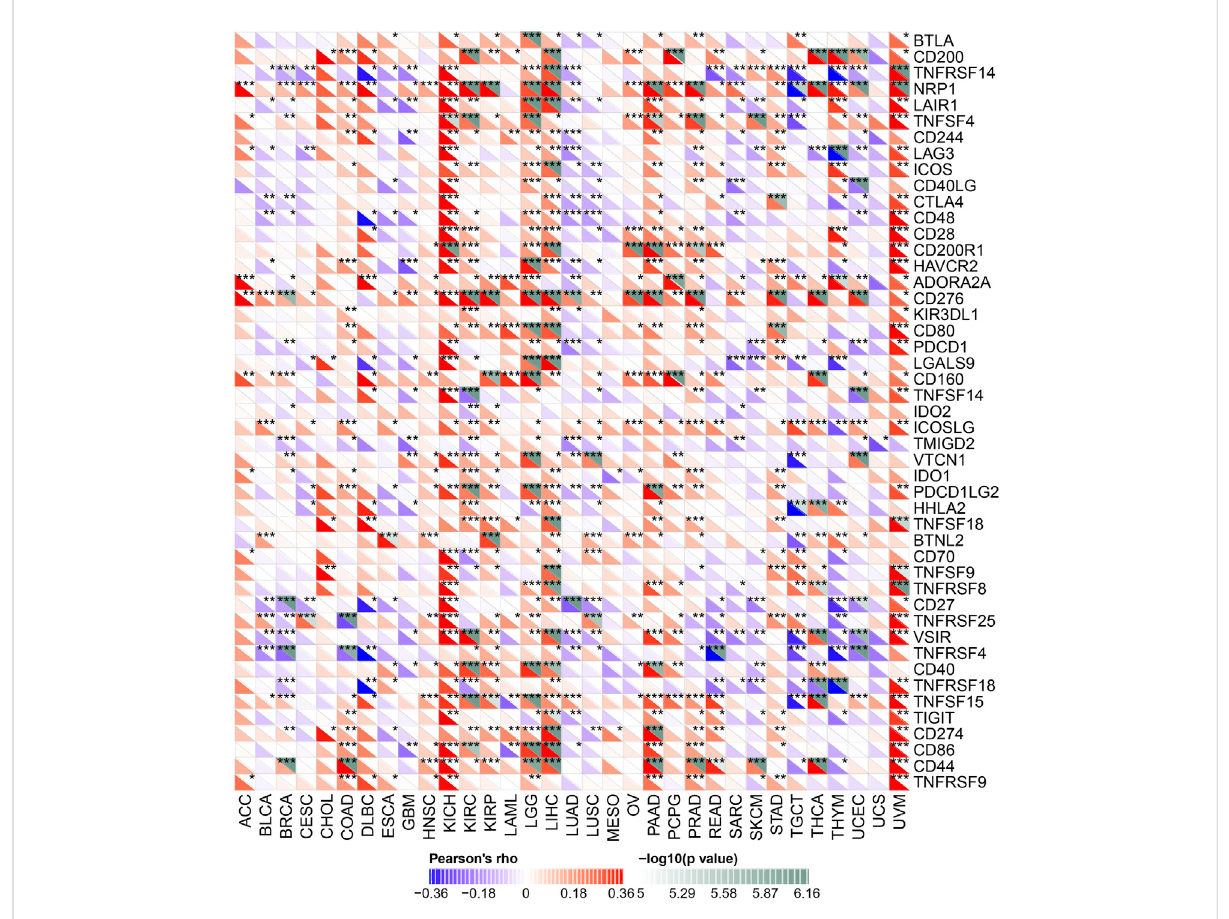
FIGURE 7 The correlation between YTHDF2 expression and pan-cancer immune checkpoint genes. * p < 0.05; ** p < 0.01; *** p <